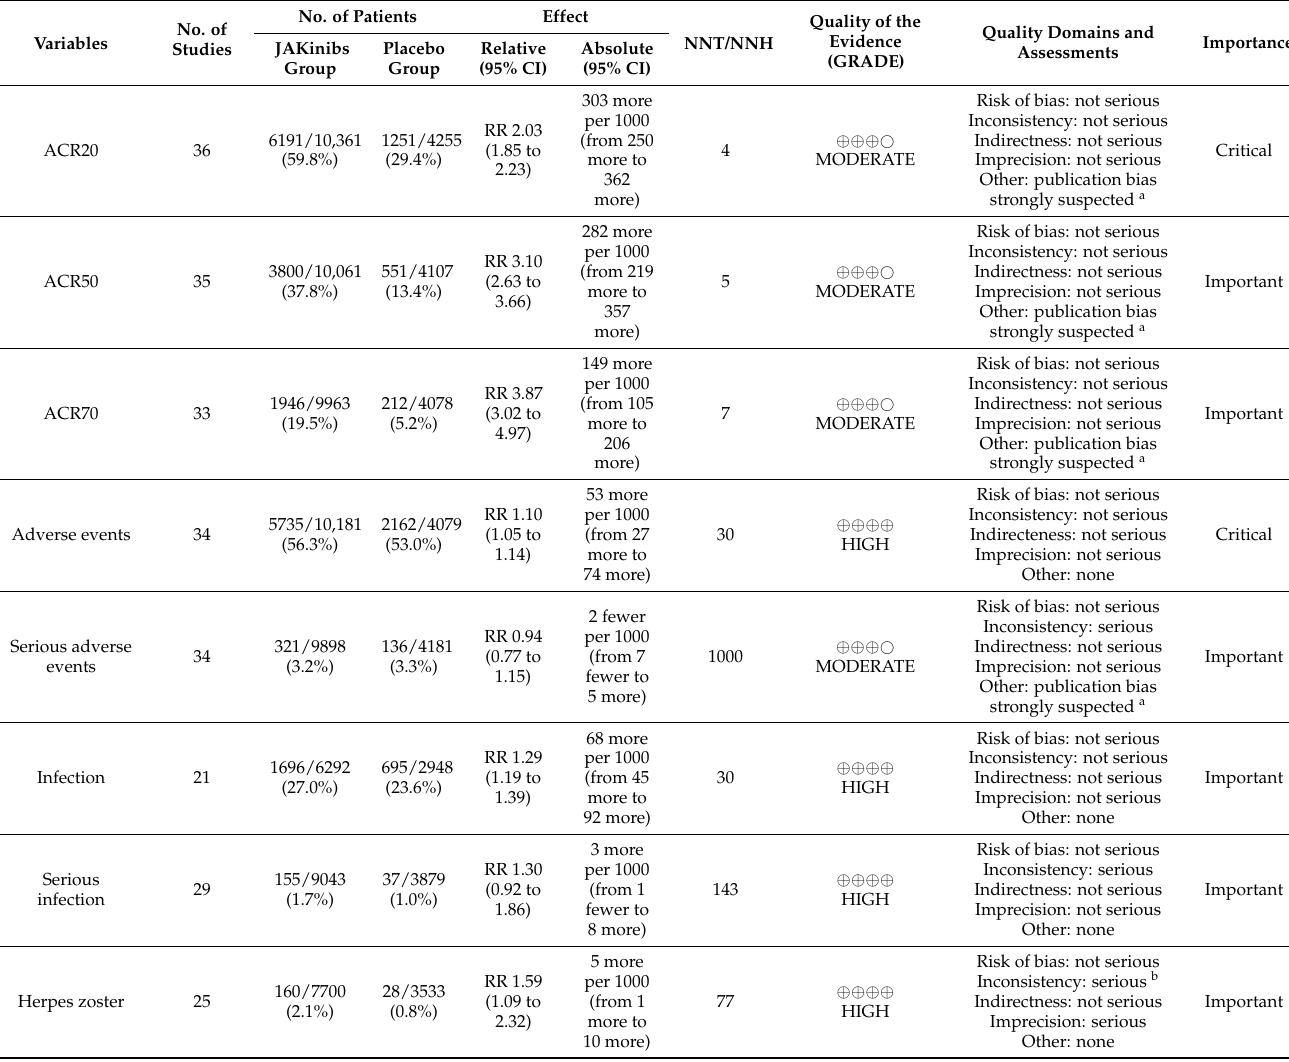
Table 3. Summary of findings, including GRADE quality assessment of evidence from